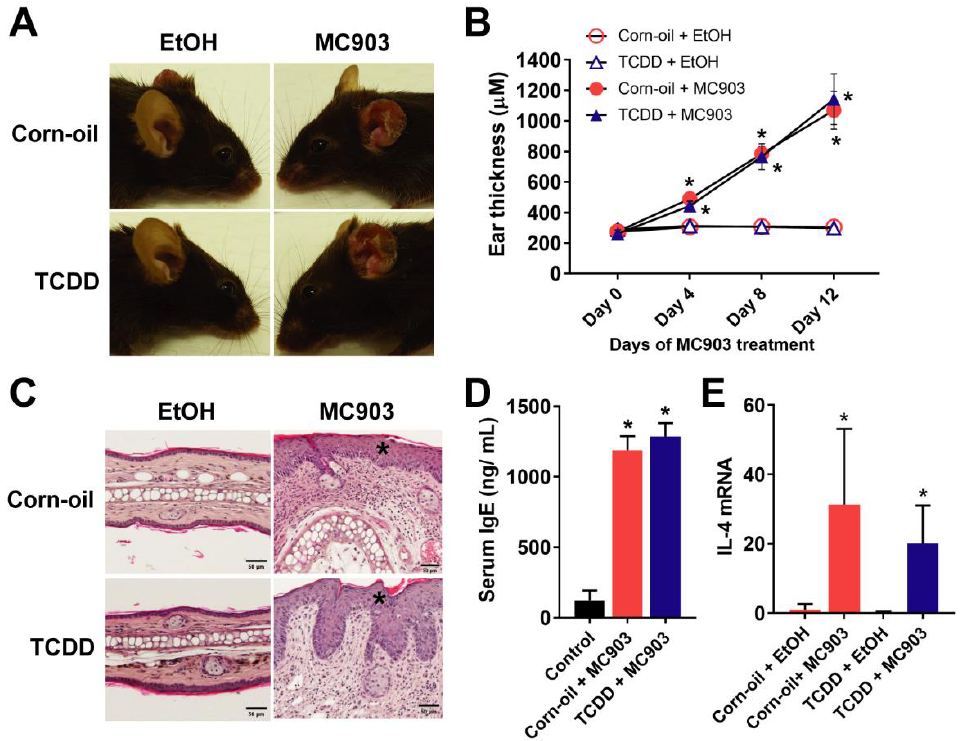
Figure 3. Effects of TCDD on topical MC903-induced AD-like dermatitis. MC903 (2 nmol in 25 µ L EtOH) or EtOH (vehicle control) was applied once daily for 14 days to ears of mice exposed to either corn-oil or TCDD (5 µ g/kg bw) in utero. ( A ) Representative images of the gross appearance of MC903-treated ears at the end of the treatment. ( B ) Thickness of the ears measured on indicated days of MC903 treatment ( n = 5). Graph displays the mean values ± SDs. Data were analyzed by two-way ANOVA followed by the Tukey test. * p < 0.05, compared to EtOH control for each treatment. ( C ) Representative images of H&E staining of ear sections at day 14. Scale bar = 50 µ m, * identifies epidermal hyperplasia. ( D ) Total serum IgE ( n = 5) at the end of MC903 treatment. Bar graph displays the mean values ± SDs. Data were analyzed by one-way ANOVA followed by the Tukey test. * p < 0.05, compared to vehicle control. ( E ) IL-4 mRNA levels measured by qPCR in skin tissue ( n = 5) at the end of MC903 treatment. Graph displays the mean values ± SDs. Data were analyzed by two-way ANOVA followed by the Tukey test. * p < 0.05, compared to EtOH control for each treatment. Abbreviations: TCDD, 2,3,7,8-tetrachlorodibenzo- p -dioxin; AD, atopic dermatitis; EtOH, ethanol; bw, body weight; H&E, hematoxylin and